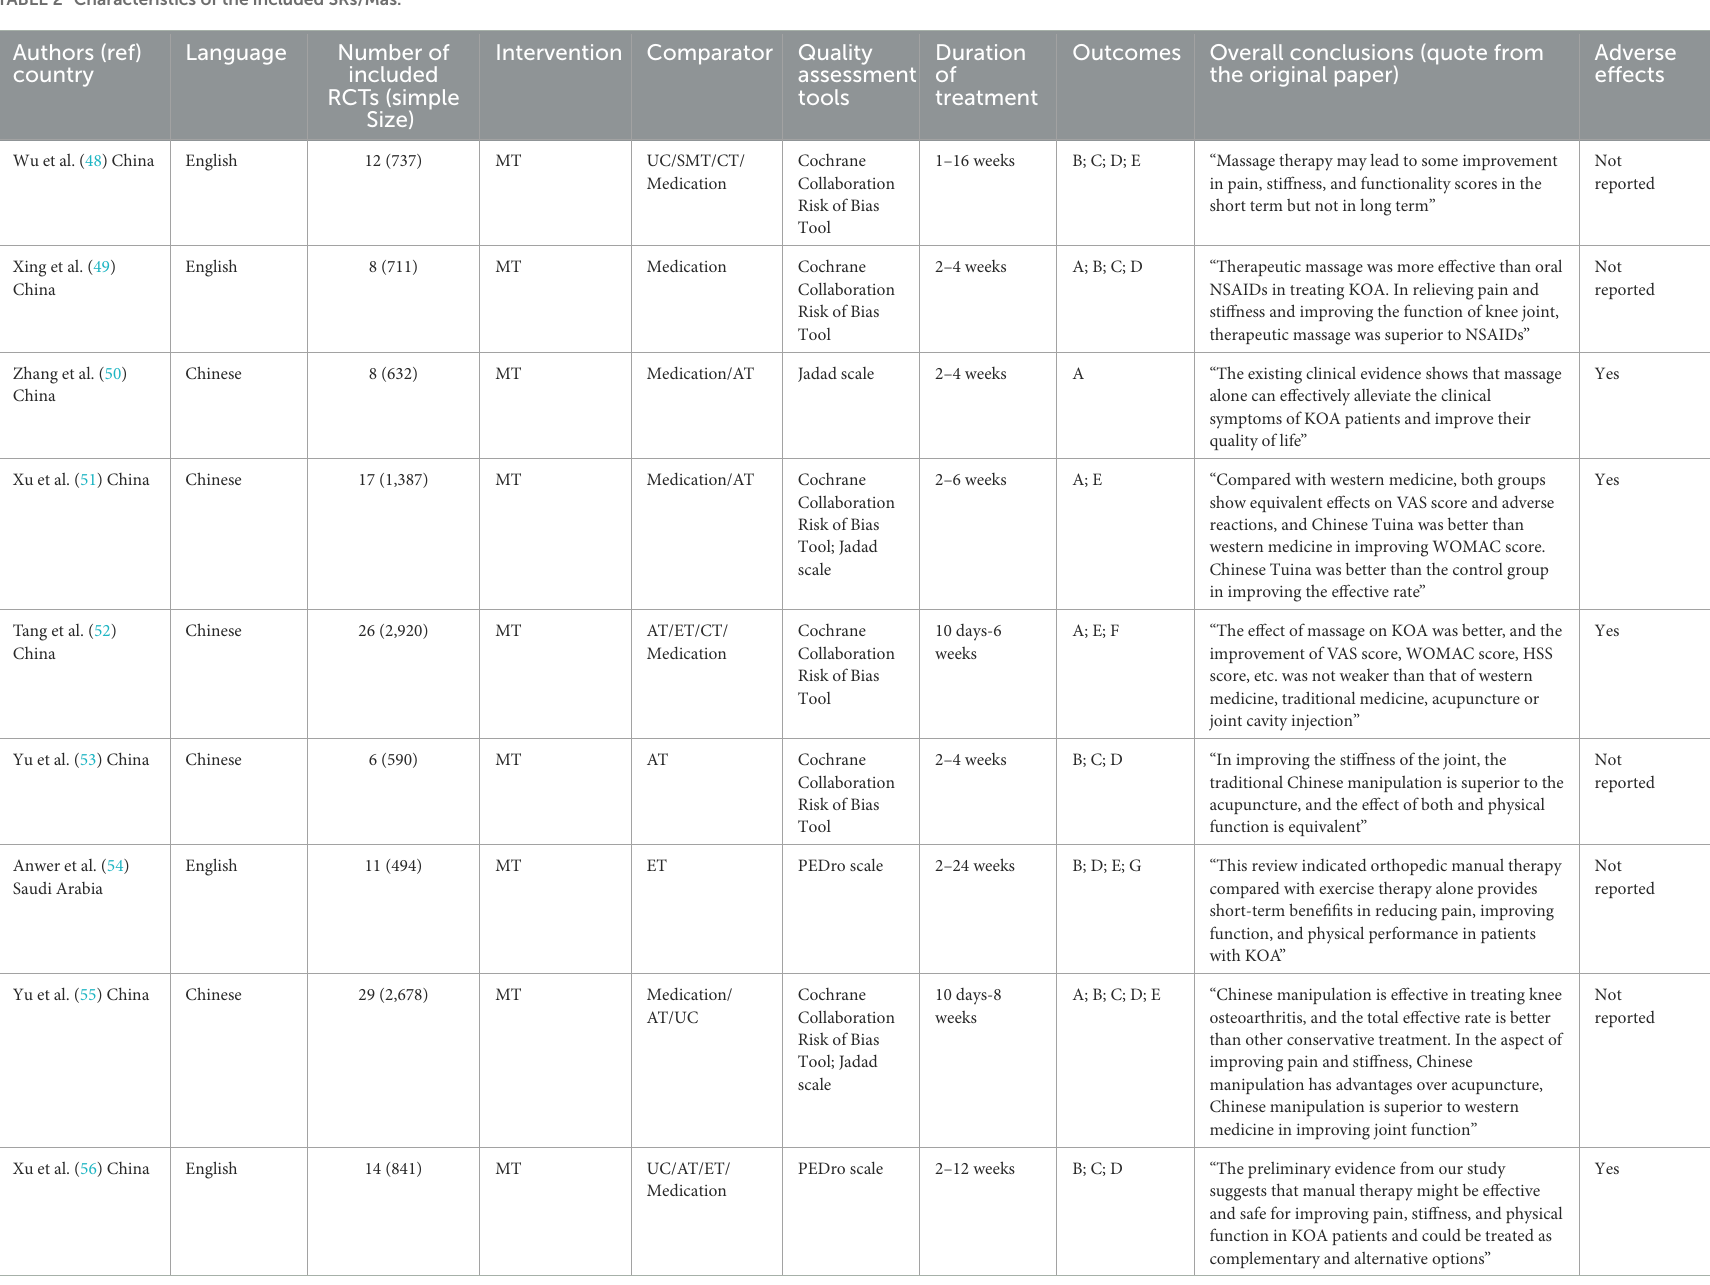
TABLE 2 Characteristics of the included